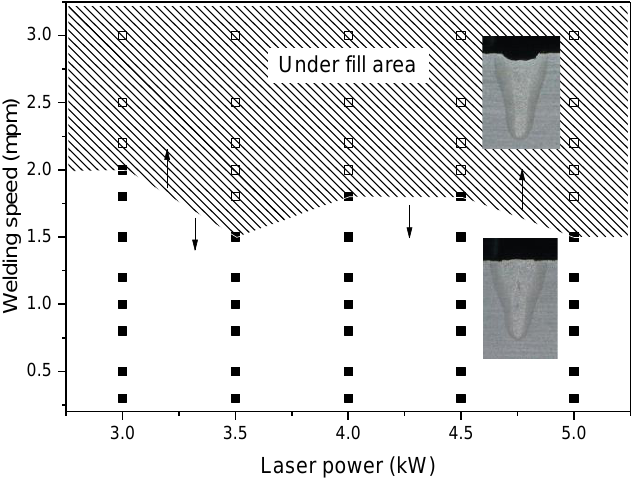
Figure 16. Under-fill phenomenon of A553-1 weld in high-speed section.